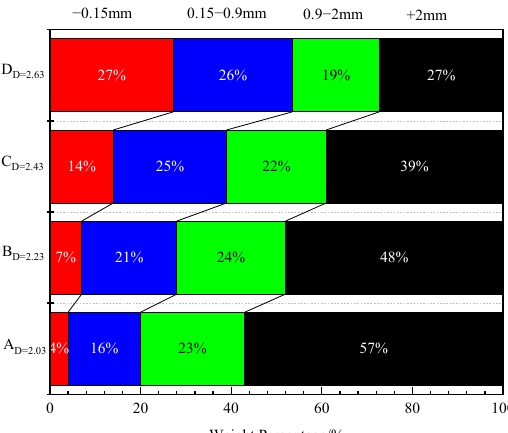
Figure 4. Mass percentage of four kinds of ores samples within each particle size range.